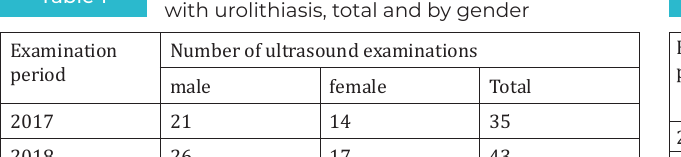
Volumes of ultrasound examination of patients with urolithiasis, total and by gender